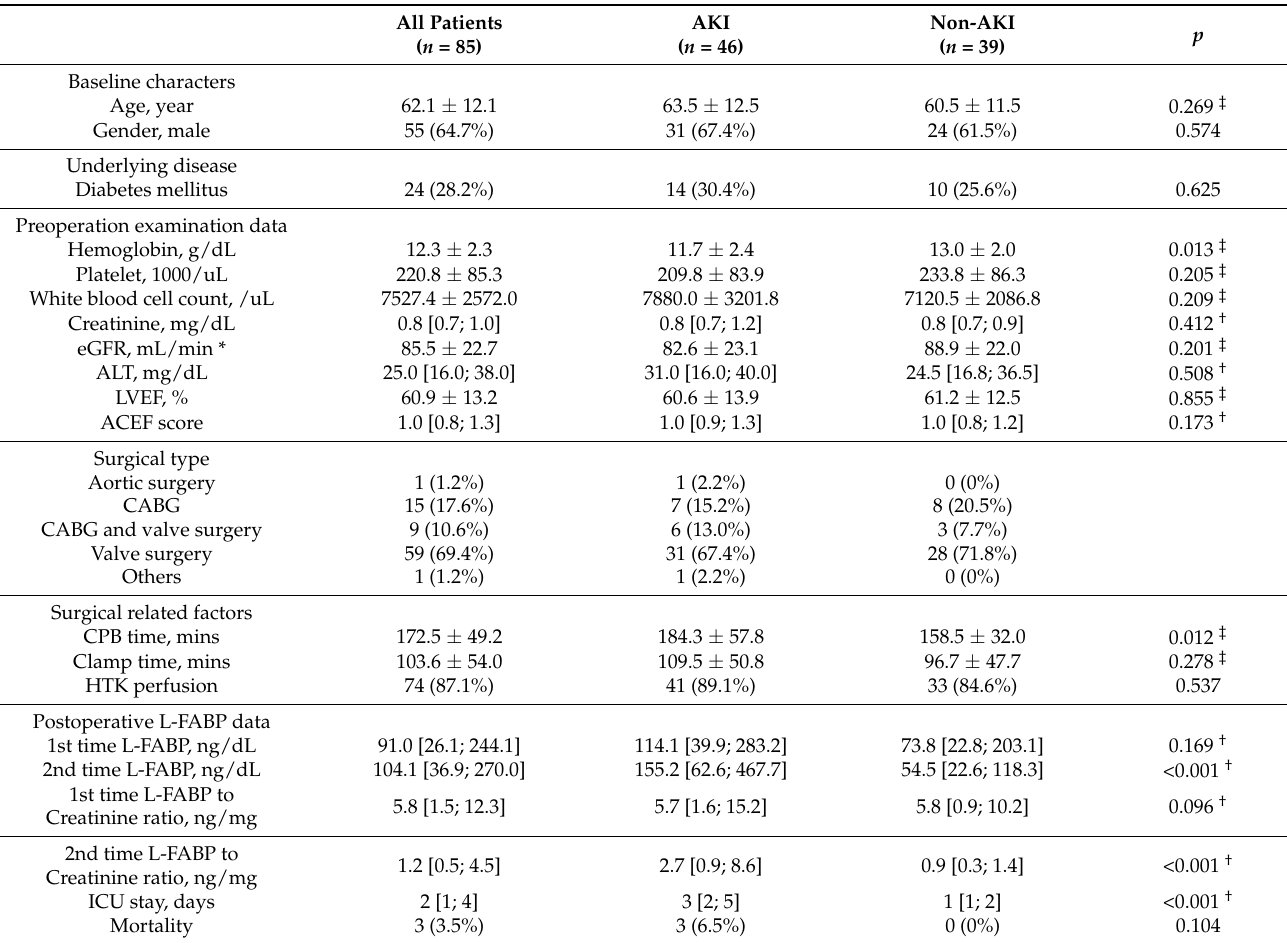
Table 2. Baseline characteristics and outcomes of the patients after cardiovascular surgery with bypass times over 120 min.